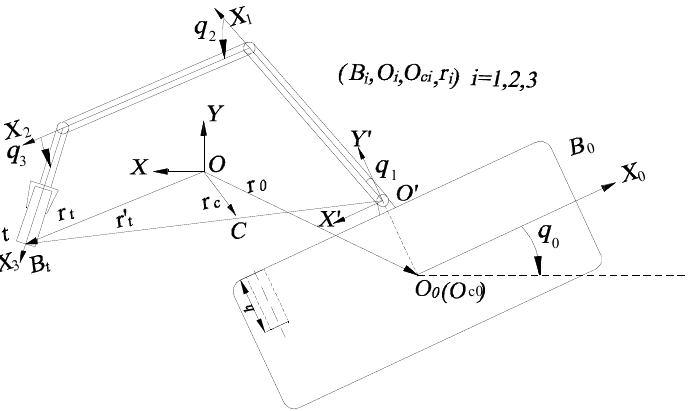
Figure 1. Three-link single-arm rigid space robot structure diagram.